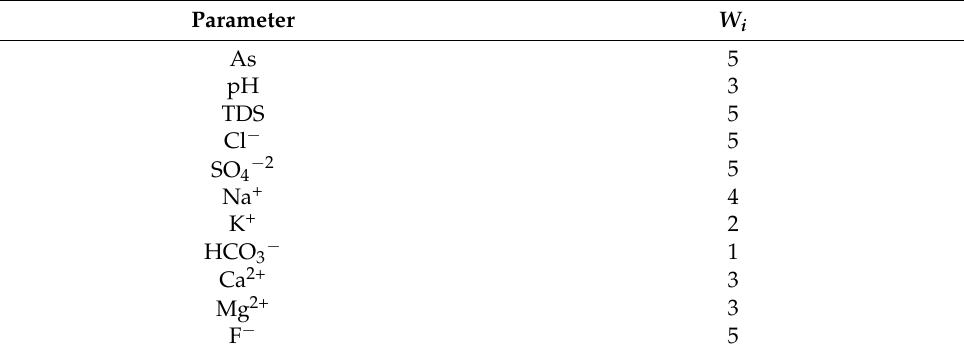
Table 2. The weight of each chemical parameter considered in this